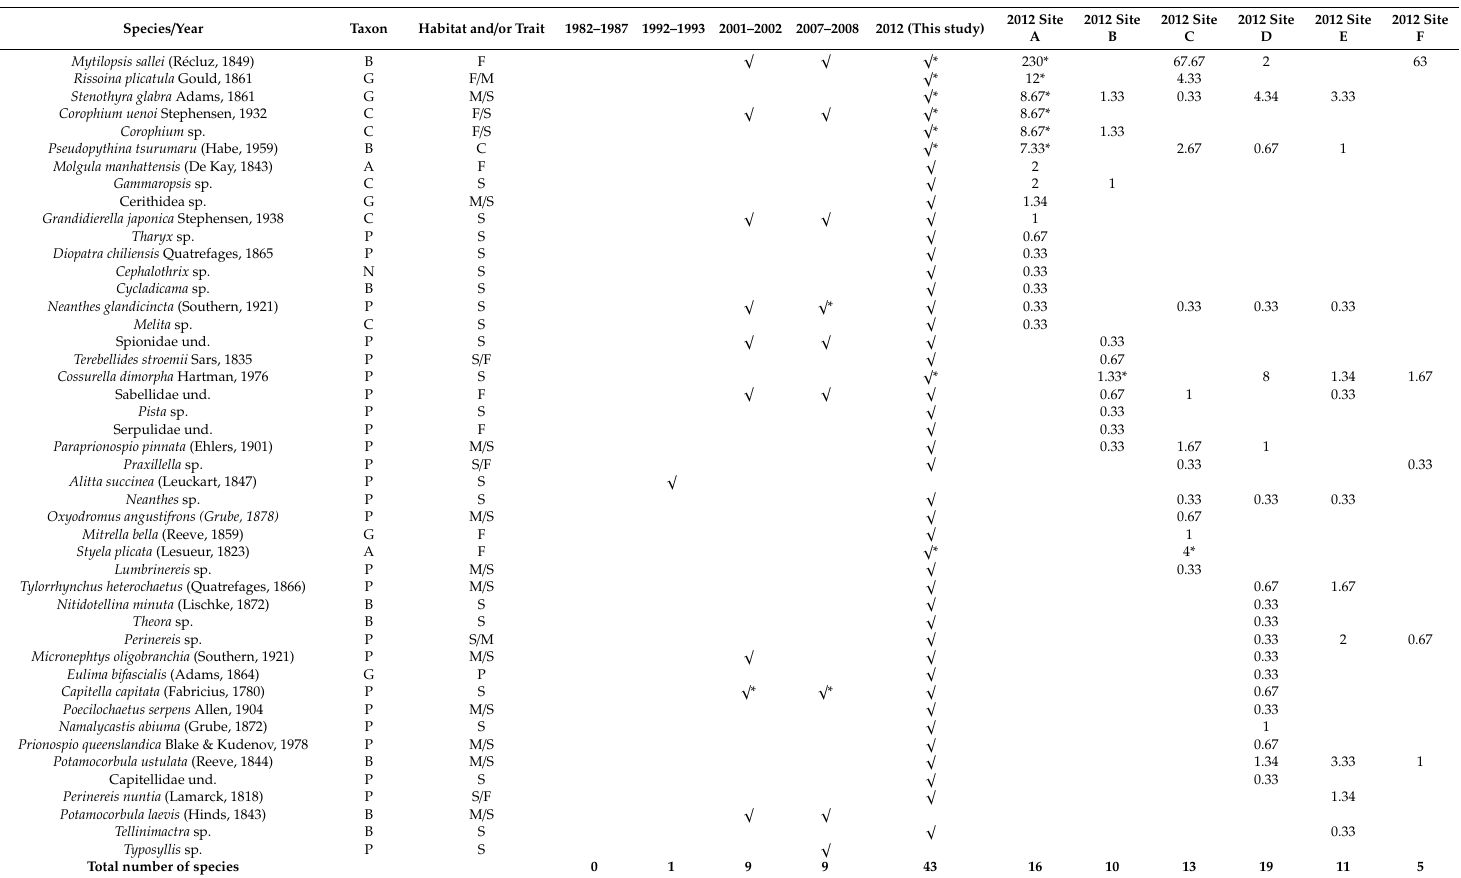
Table 4. Changes in species number and composition of macrozoobenthos collected from the bottom sediment in the Yundang Lagoon in the years before the restoration (1982–1987), and during the first (1989–1992) and the third (2001 to present) phase of restoration. Information prior to the present study (2012) was gathered from Xu et al. [43] for 2007–2008, and from Ye et al. [29] and unpublished reports for the other periods. The dominant species in each period / Site are marked by *. For the present study (2012), the abundance (ind. 600 cm − 2 ) per site is also reported as the mean of three stations.